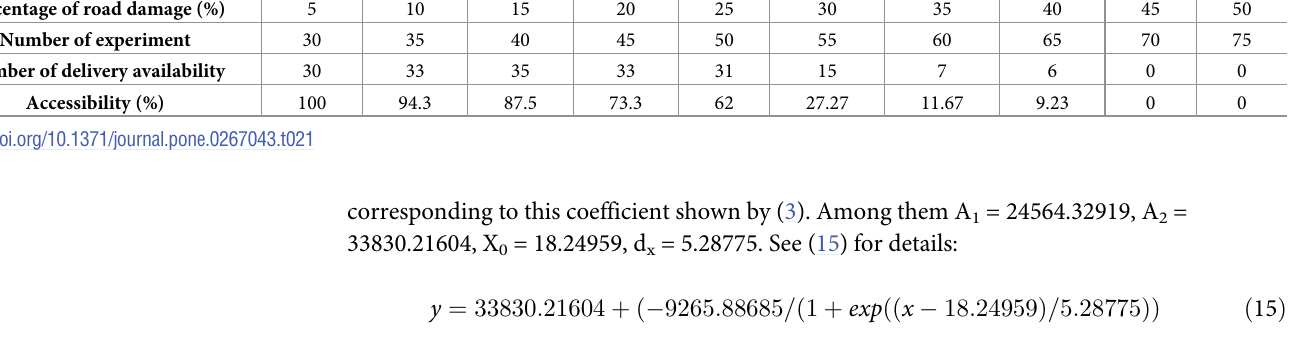
The control tests identify that the results satisfy the obtained delivery curve by changing dif- ferent delivery tasks. In these three indicators, the percentage of damaged roads to the control tests have the same values of the corners of the curve, which verifies the universality of the three results of distribution costs, distribution accessibility and distribution efficiency, and concludes that the road network has a general rule for delivery. These results offer new ideas about future research on the road network delivery.